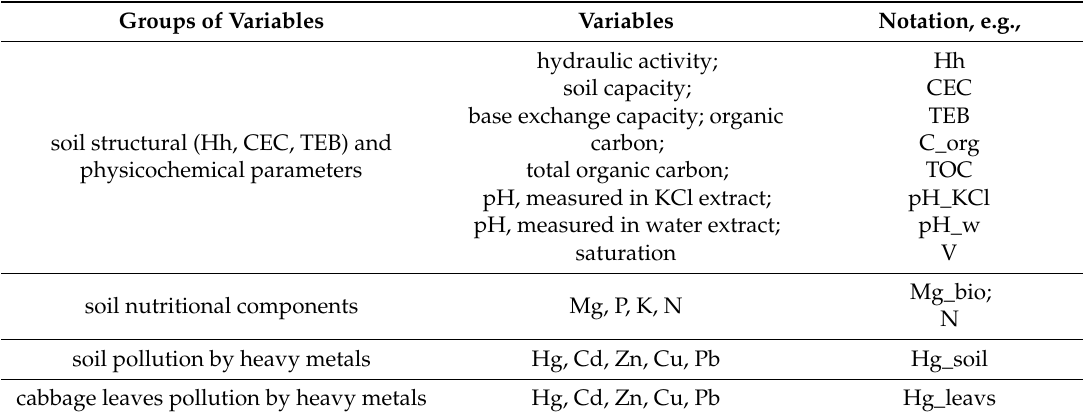
Table 1. The conditional groups and variables belonging to each of